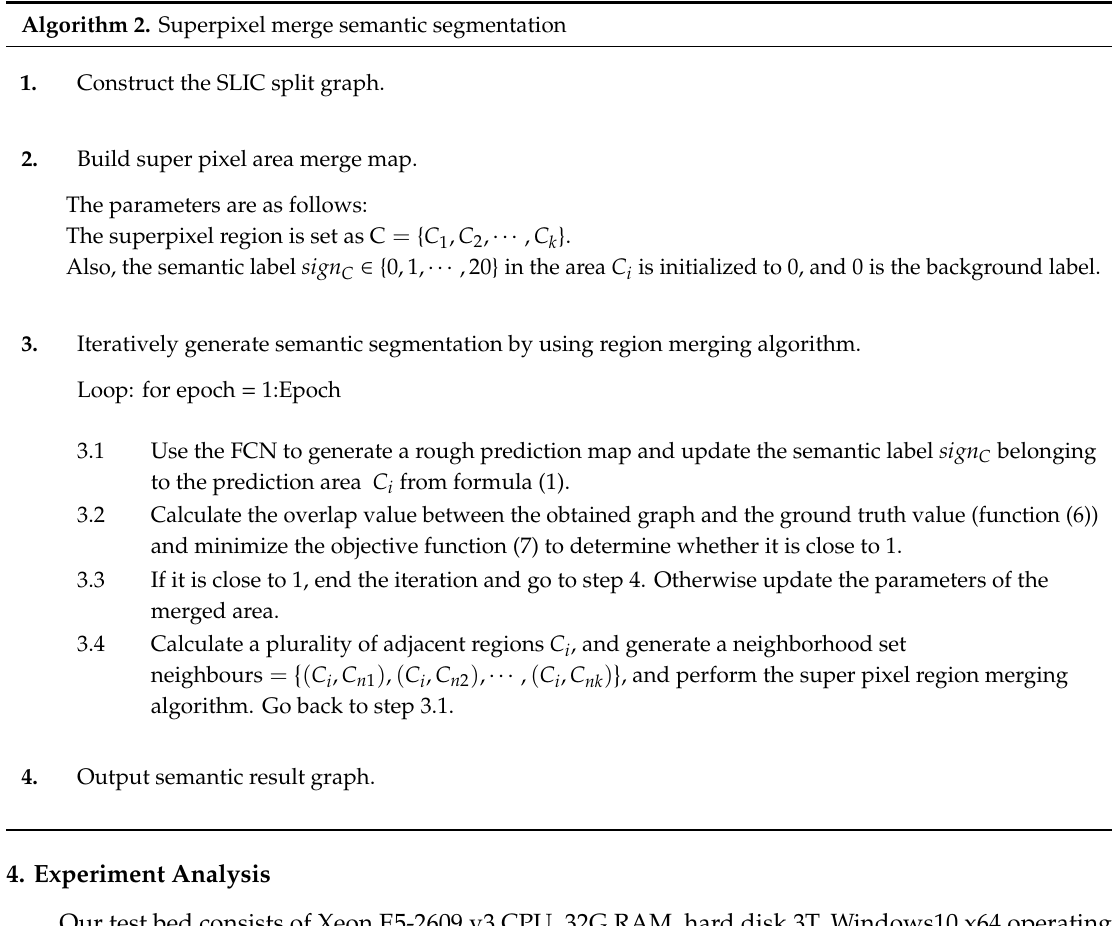
Algorithm 2. Superpixel merge semantic segmentation